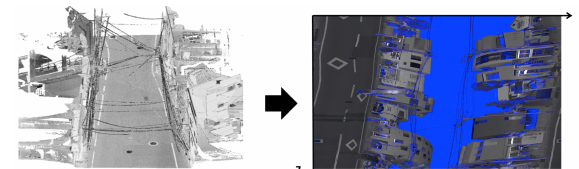
Figure 8. Projecting point cloud onto 2D grid